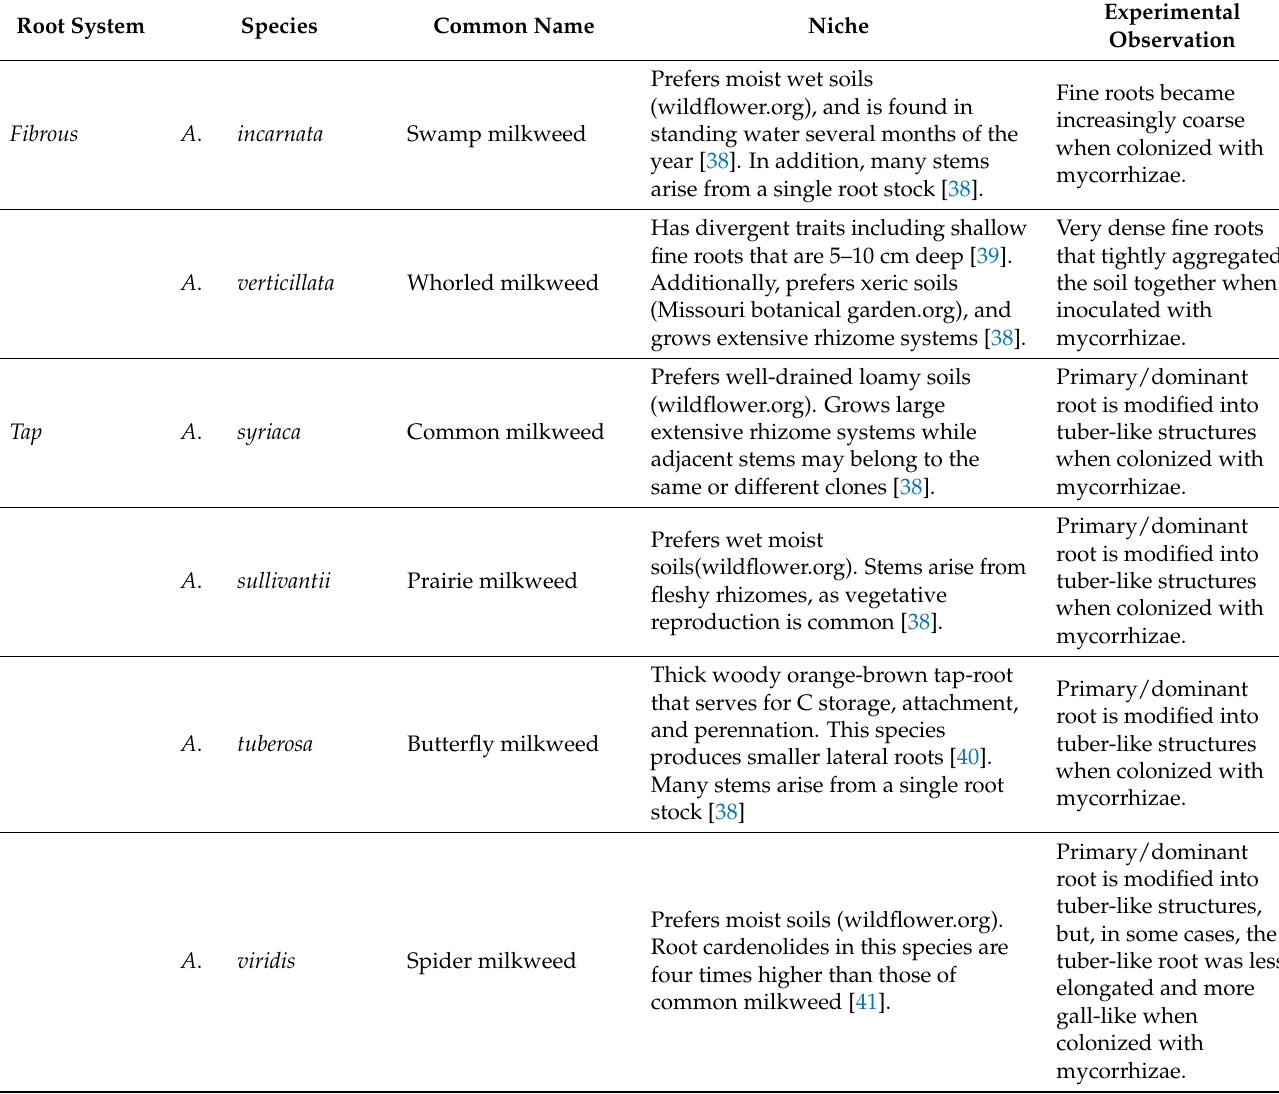
Table 1. Root system, milkweed, and qualitative observations of the 6 Asclepias species. Root